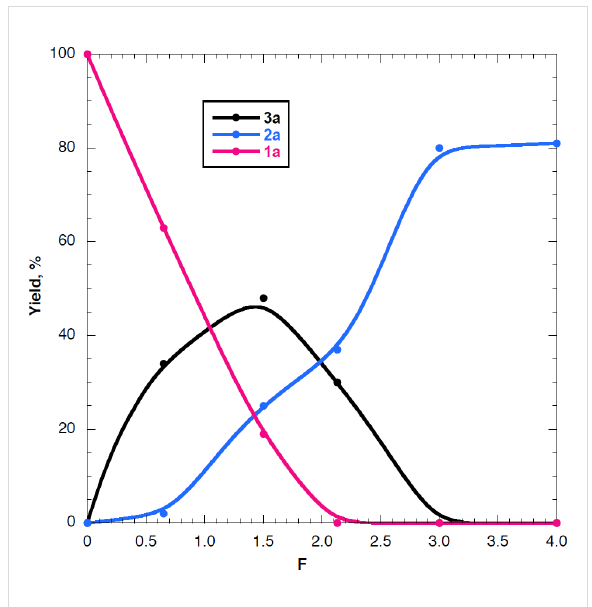
Figure 2: Variation of the amounts of 1a , 2a , and 3a with the number of Faradays of 1a